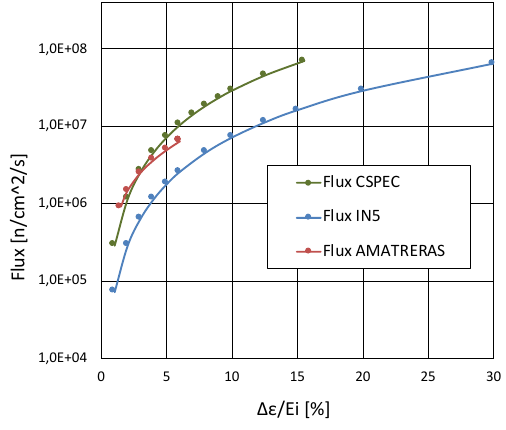
Fig. 8. Flux variation as a function of energy